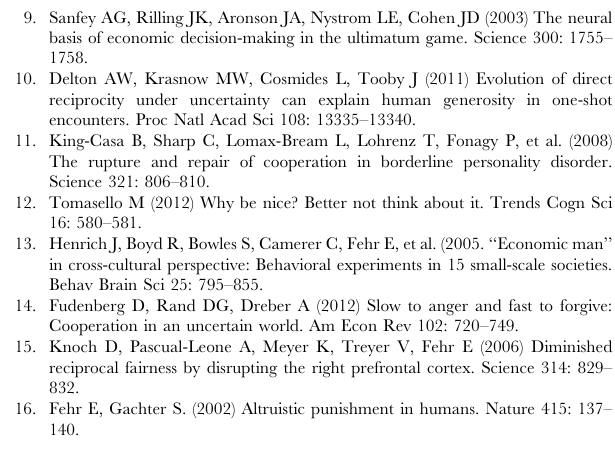
Figure S1 Perceived Fairness of Offers in the Ulimatum Game. Table S1 Experimental Details of Previous Studies Examining Time Constraints in UG Responder Accep- tance